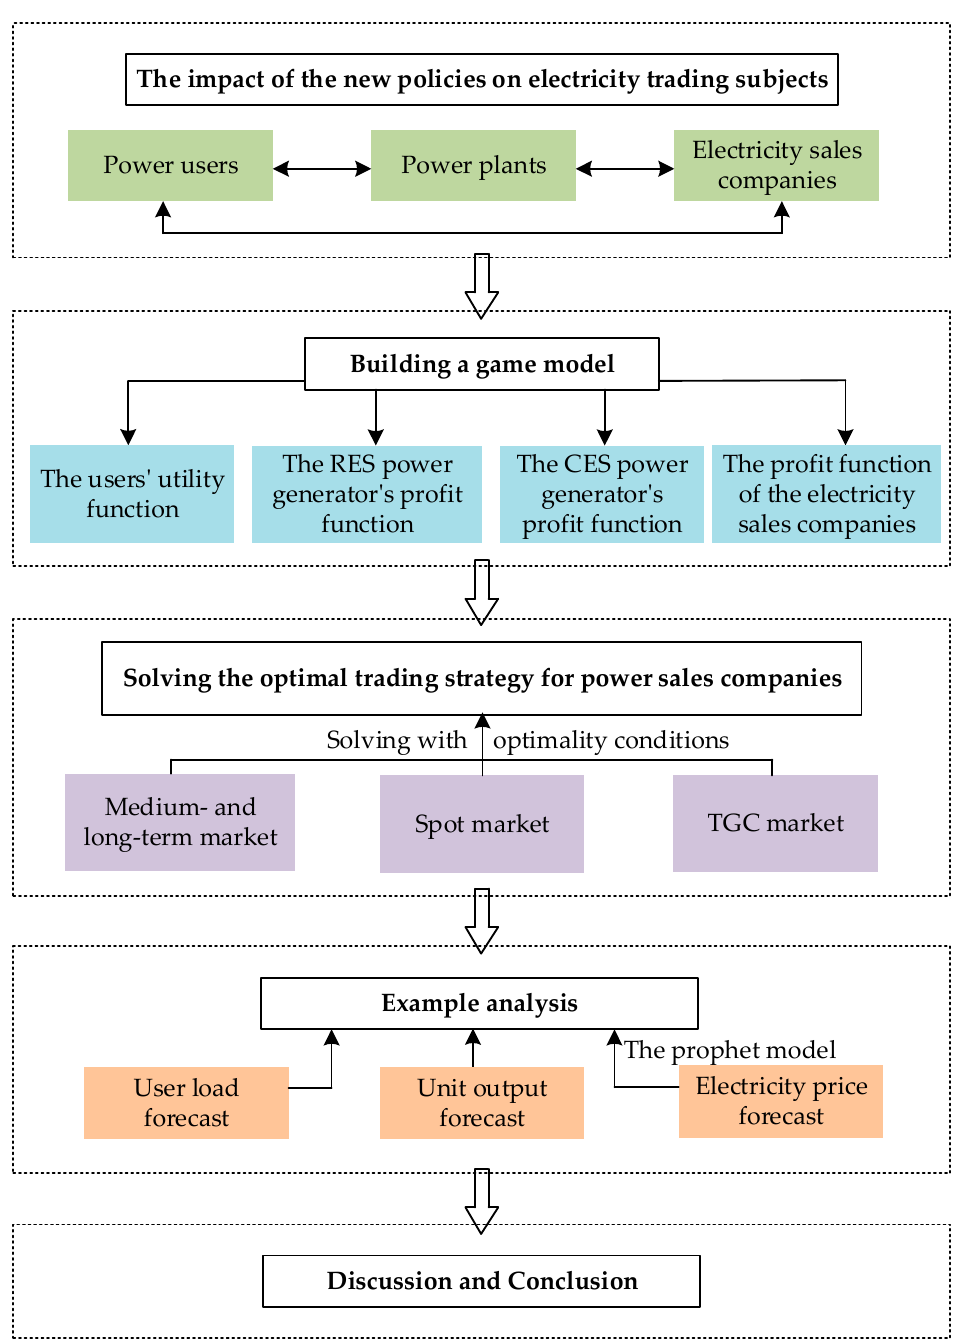
Figure 1. The research design.